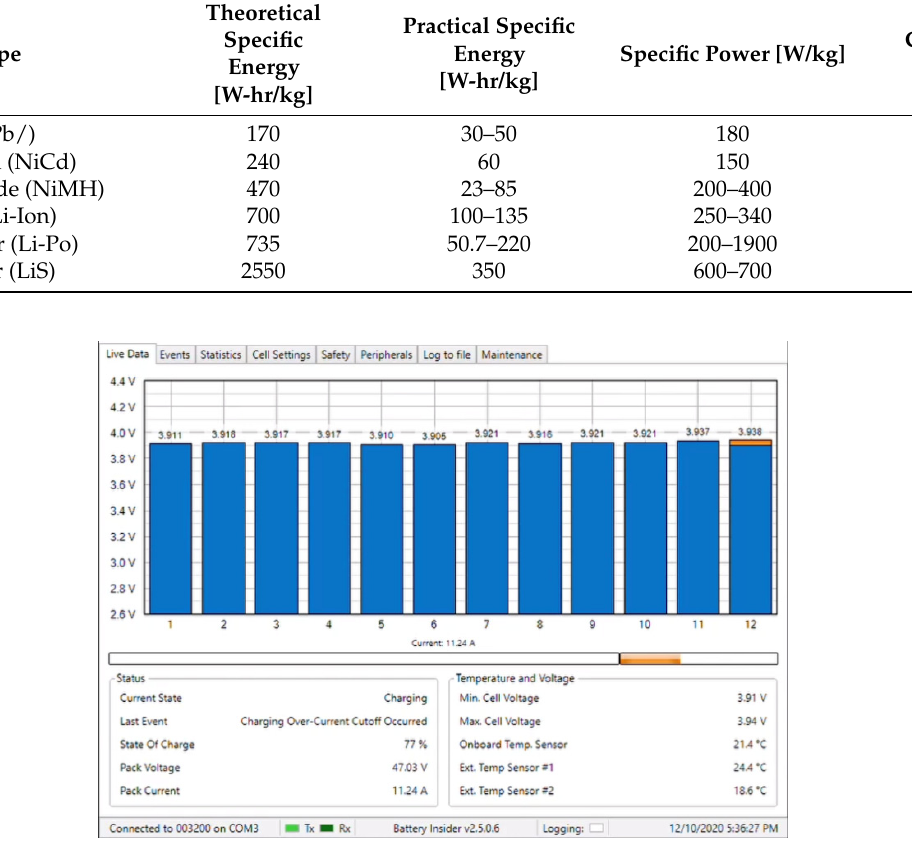
Figure 6. Screen capture of the BMS showing cell voltages nearly leveled during charging.